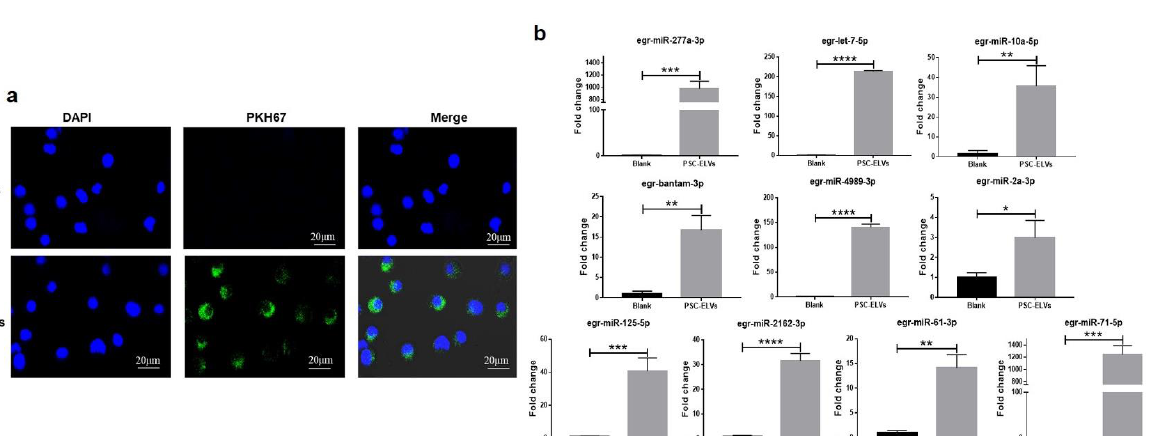
Figure 1. Identification of E. granulosus protoscoleces-derived exosome-like vesicles (PSC-ELVs). ( a ) Images of the rounded or cup-shaped PSC-ELVs under transmission electron microscopy (TEM). Scale bars: 100 nm; ( b ) The size distribution of the PSC-ELVs. ( c ) Western blotting analysis of CD9, enolase-1, and 14-3-3 in PSC-ELVs.